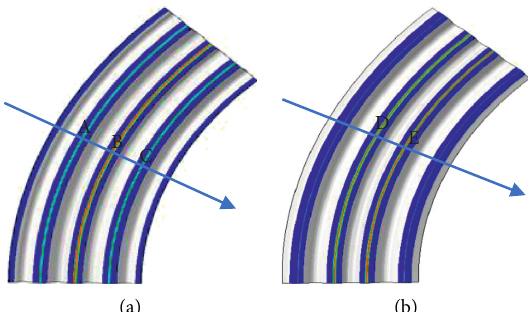
Figure 19: Contact stress distribution on the sealing surfaces. (a) Upper sealing surface. (b) Lower sealing